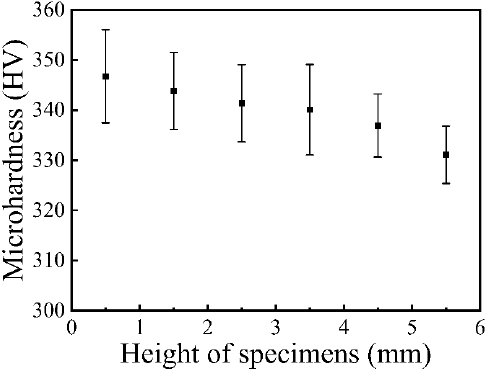
Figure 10. Vickers microhardness of FGH96 by SLM at different heights of specimens.